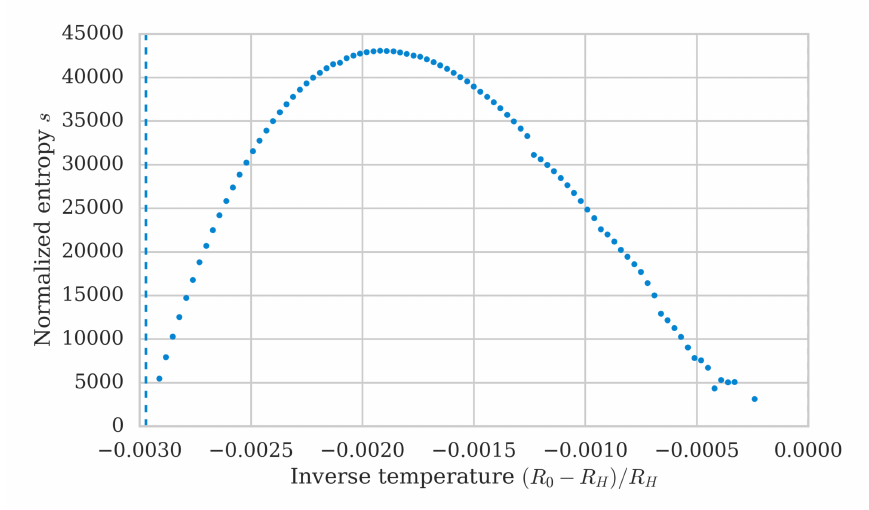
Figure 8 . Numerical estimation of the AdS string star normalized entropy s as a function of ( R ) /R . The numerical calculation was done for the d = 6 heterotic string. The blue 0 − R H H vertical line is the AdS Hagedorn temperature R